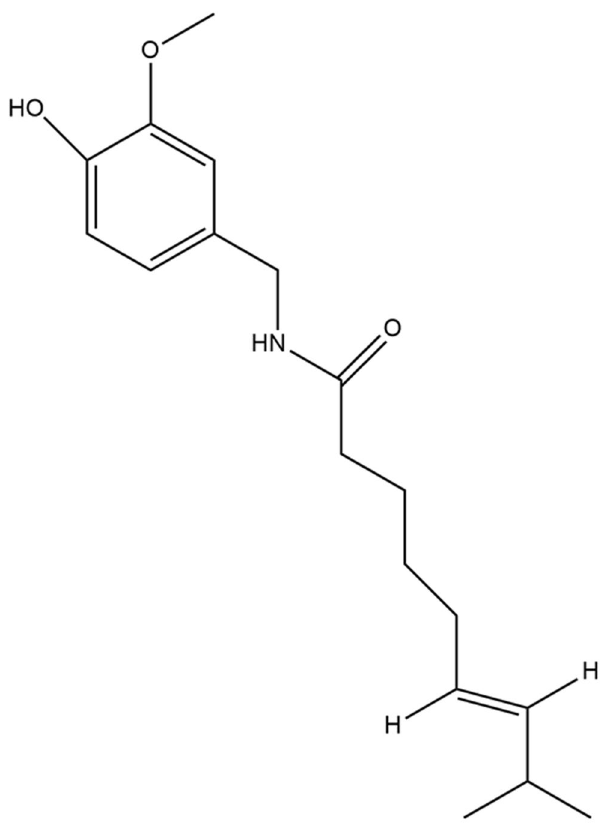
Figure 1. The molecular structure of capsaicin (C 18 H 27 NO 3